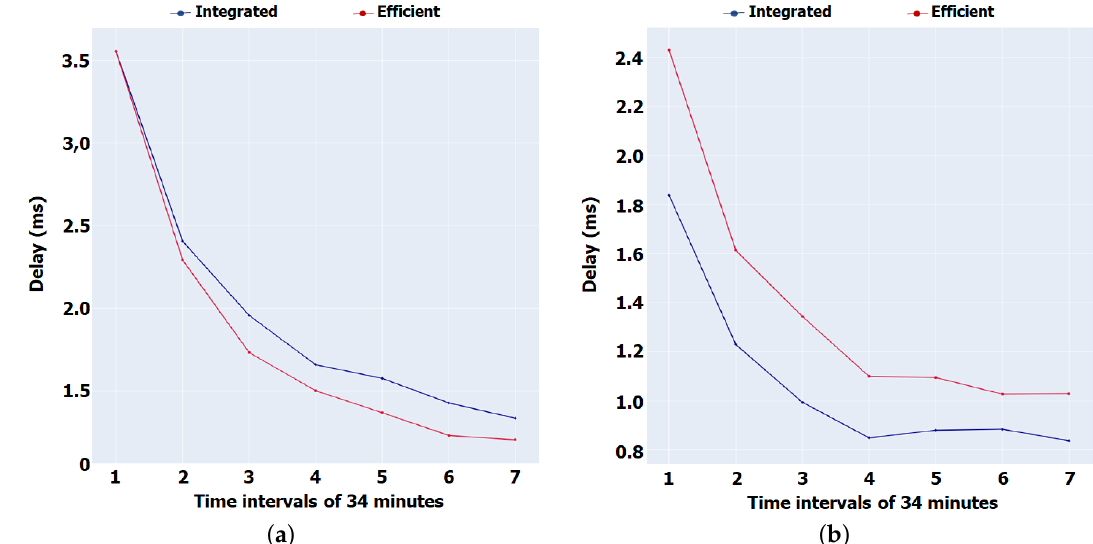
Figure 9. Transmission delay. ( a ) Aveiro scenario. ( b ) Porto